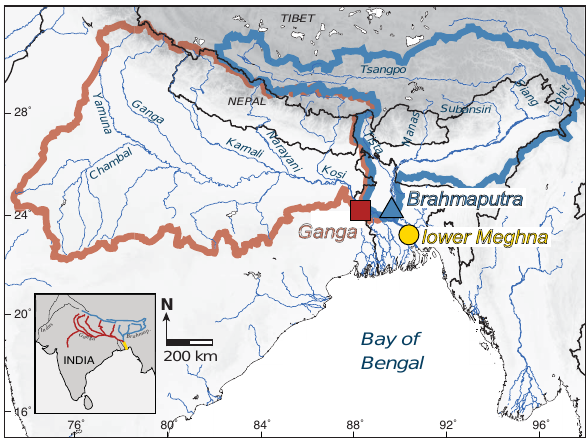
Figure 1. Map of the Ganga and Brahmaputra basins (respectively delimited in red and blue) and sampling locations of sediments used in this study on the Ganga River, the Brahmaputra River and the lower Meghna River, which is the confluence of both rivers.